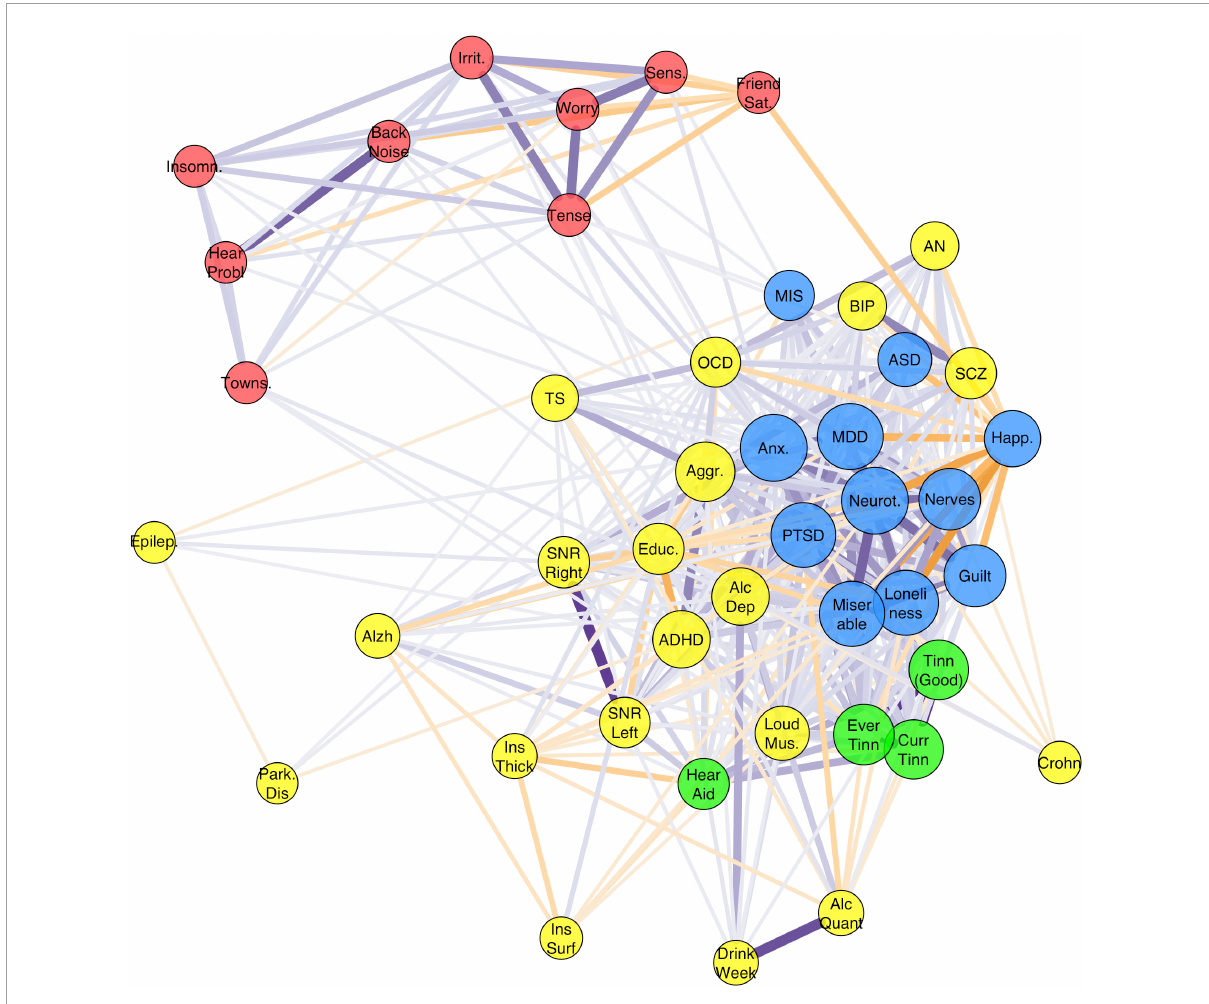
FIGURE4 Graph of the full genetic correlation matrix. Vertex colors are based on Louvain clustering algorithm. Per vertex, only the top 10 edges are shown that are over 0.10. Node size is based on the Eigen centrality of the trait calculated from the weighted correlation matrix (absolute values). Misophonia clustered with the Depressive disorders cluster [major depression disorder (MDD), post-traumatic stress disorder (PTSD), and Anxiety] which also holds related personality traits (including neuroticism, guilt, miserableness, loneliness) (blue). Irritability and related traits (worry, sensitivity, tense) cluster with hearing problems (without or with background noise), insomnia, friendship satisfaction, and Townsend index (red). Tinnitus traits clustered with “hearing aid user” (green). The remaining cluster (yellow) holds a variety of traits, which includes neuropsychiatric disorders attention deficit and hyperactivity disorder (ADHD) and autism spectrum disorder (ASD), neurological disorders, substance use disorders, psychotic disorders (schizophrenia, SCZ; bipolar disorder, BIP), obsessive-compulsive-related disorders (OCD; Tourette’s Syndrome, TS; AN), and the insula